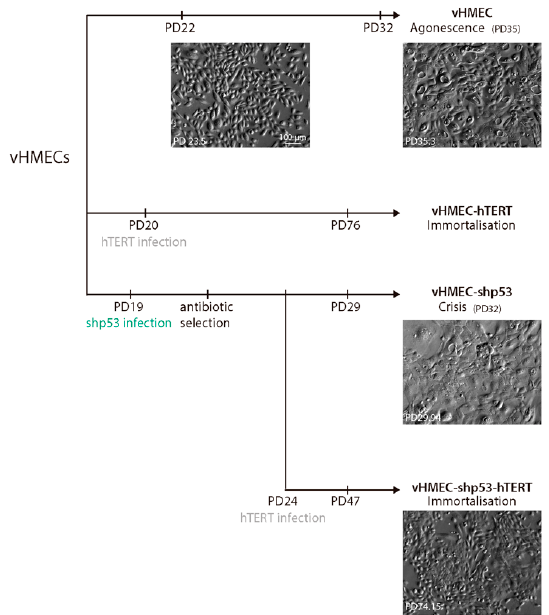
Figure 1. Scheme of the generation and analysis of different vHMEC cell lines. Young vHMECs were immortalised by transduction with hTERT containing lentivirus at PD20 to generate immortalised vHMECs. In addition, young vHMECs at PD19 were also infected with lentiviral particles containing the short hairpin RNA of p53 under the hU6 constitutive promoter to generate p53 compromised finite vHMECs. After a period of selection with puromycin, the cells were expanded and subsequently immortalised with the hTERT lentivirus at PD24. Cytogenetic analysis was performed at PD22 and PD32 for young and aged vHMECs, respectively. Immortalised vHMECs (vHMEC-hTERT) were karyotyped at PD76 and at PD130 (not shown). Finite but p53-deficient vHMECs (vHMEC-shp53) were analysed at PD29 and the immortalised cell line derivative (vHMEC-shp53-hTERT) at PD47. Phase contrast images of the different cell lines at different PD are shown. Scale bar corresponds to 100 µm.